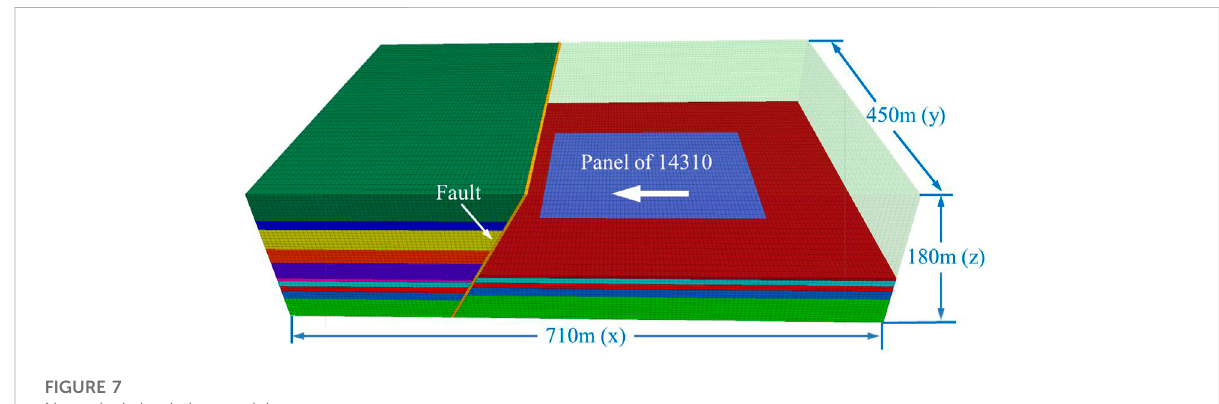
FIGURE 7 Numerical simulation model.